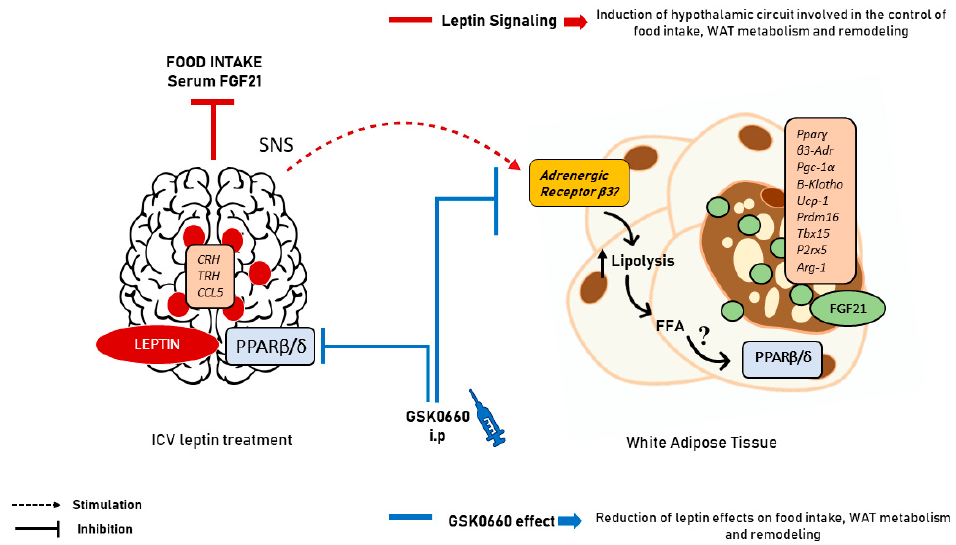
Figure 8. Scheme summarizing the effects of central leptin on eWAT. Leptin, acting through hypothalamic neural circuits and the SNS activates lipolysis in eWAT, generating probably tissue-specific PAR β / δ ligands and/or ligand precursors which, once present in adipose tissue might activate PPAR β / δ function in eWAT inducing the endogenous expression of FGF21 and the browning capacity of this tissue. The molecular nature of the ligands that might activate PPAR β / δ in eWAT, in response to the increased lipolysis induced by central leptin in this tissue is not known and remains to be determined. SNS: sympathetic nervous system; FFA: free fatty acids.